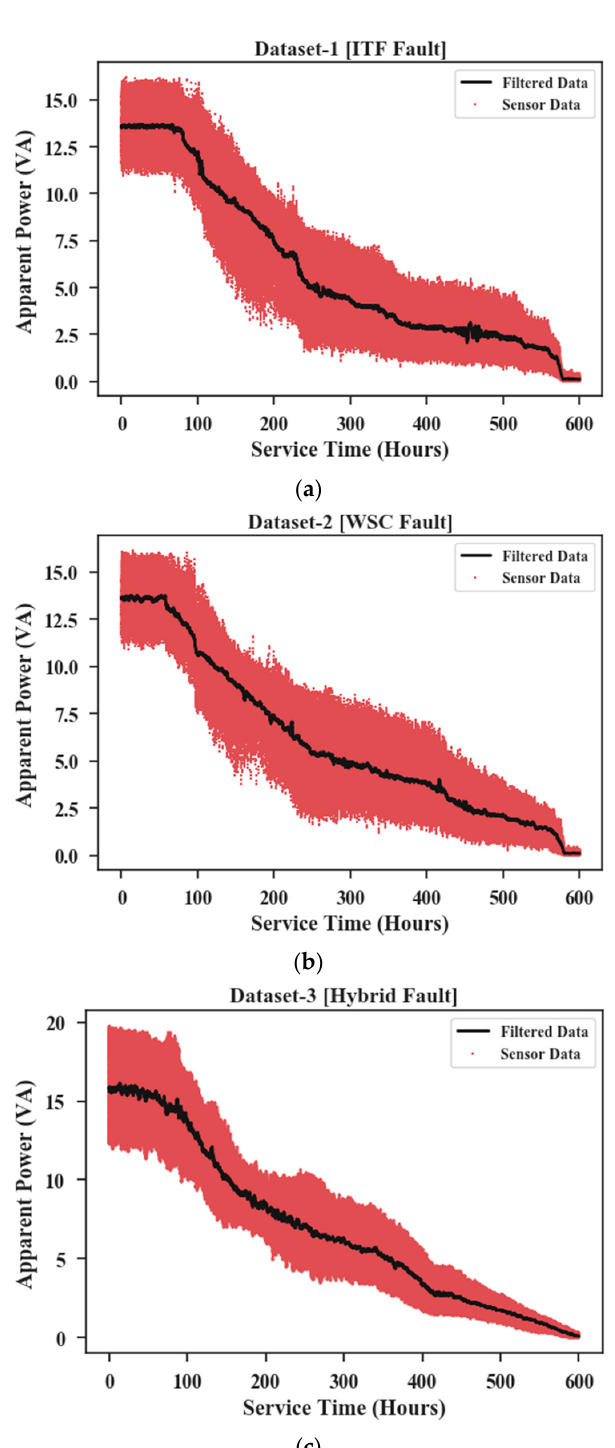
Figure 12. Degradation data of different fault states. ( a ) ITF fault, ( b ) WSC fault, ( c ) Hybrid fault